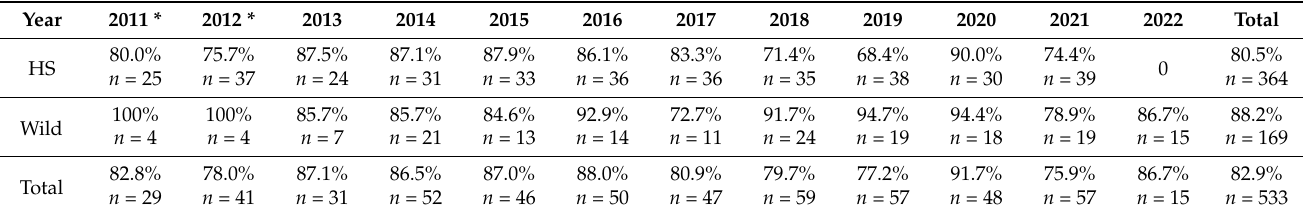
Table 2. Percentage of SbS eggs hatched in 2011–2022 using artificial incubation and those incubated